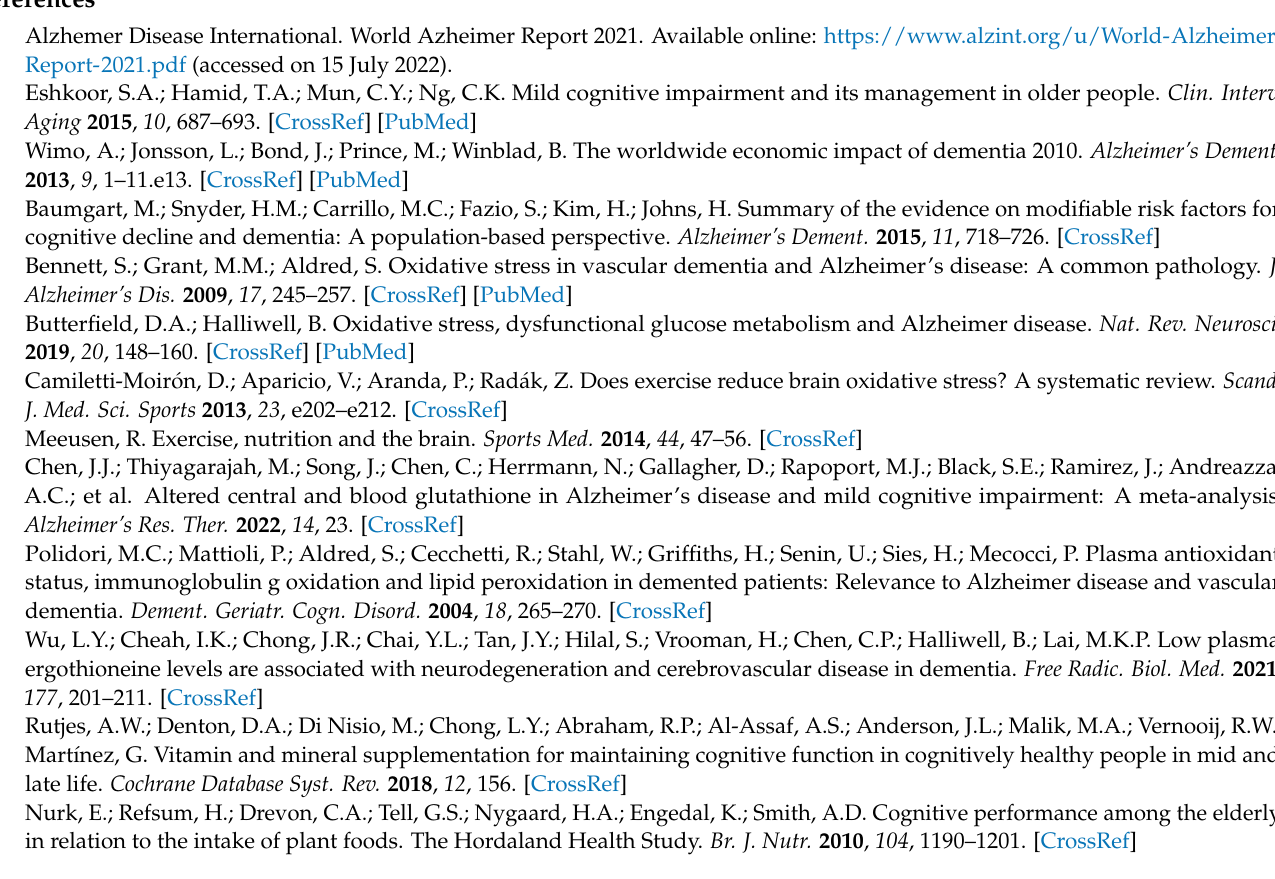
subgroups; Figure S3: Functional and cognitive trajectories in relation to baseline plasma ET stratified by clinical subgroups; Figure S4: Associations of baseline plasma ET with functional outcomes ( ≥ 1-point increase in CDR-SOB